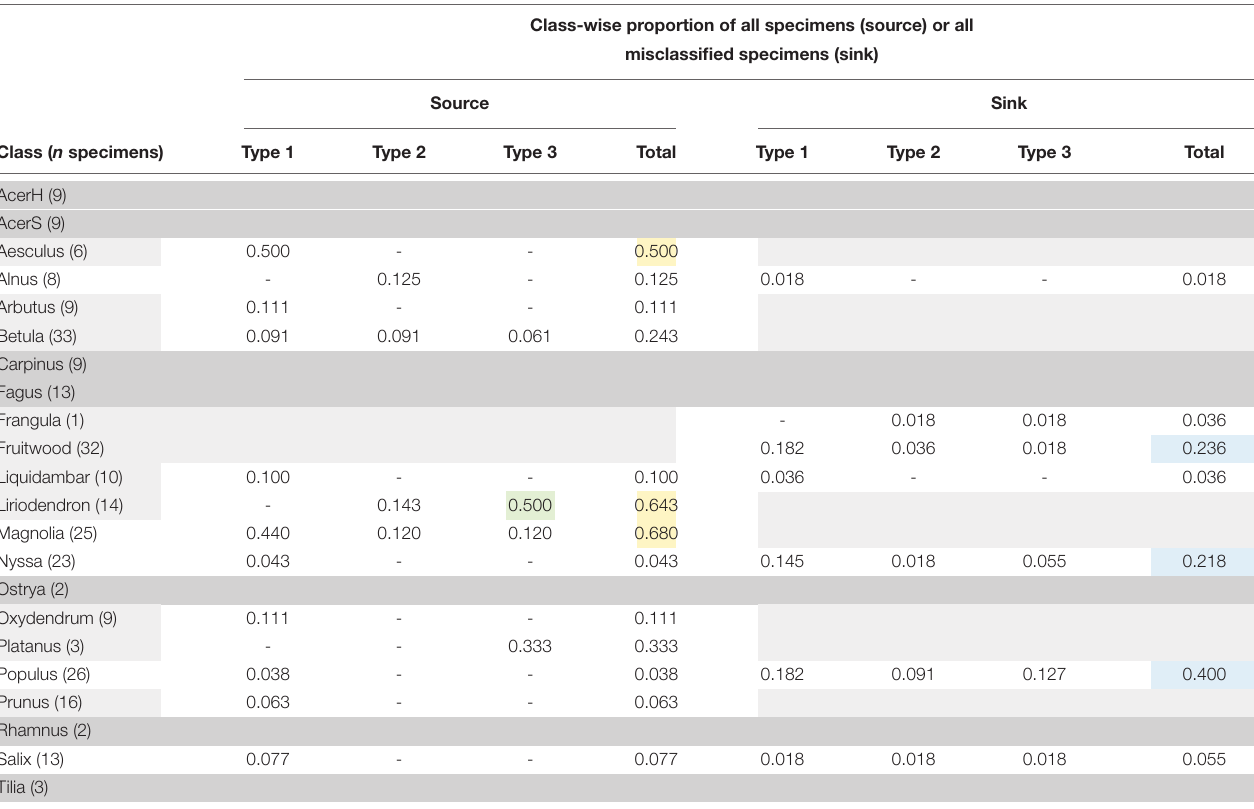
TABLE 5 | A class-wise assessment of misclassifications for the top-1 misclassified specimens in the field